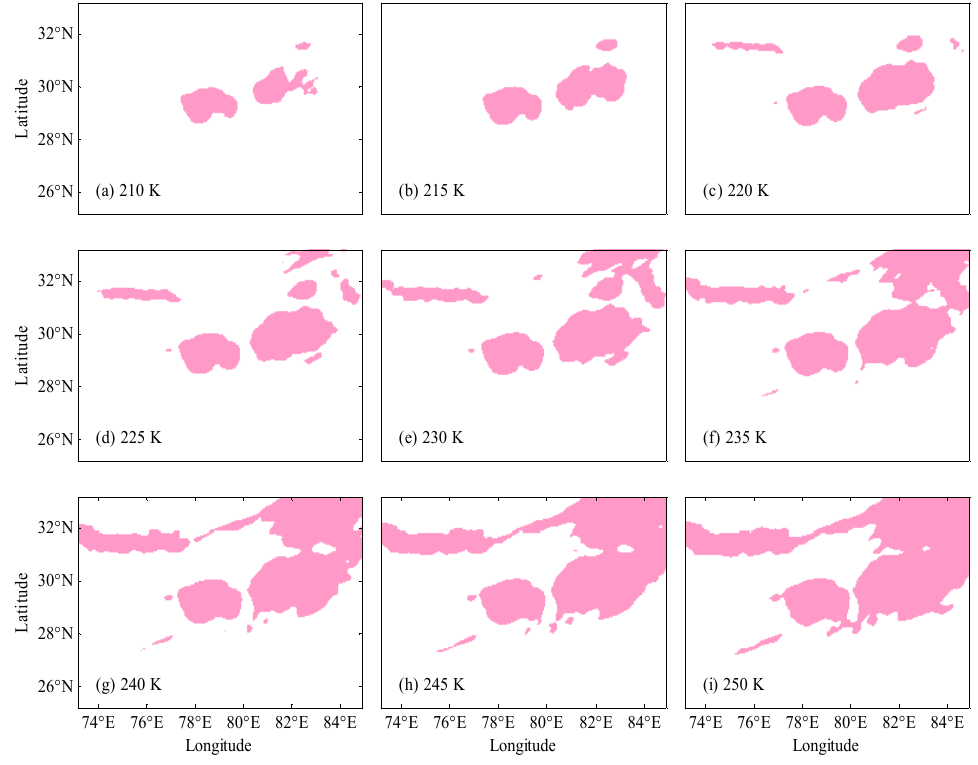
Figure 2. ( a – i ) Results of convective cloud detection by Infrared BT IR1 thresholds.